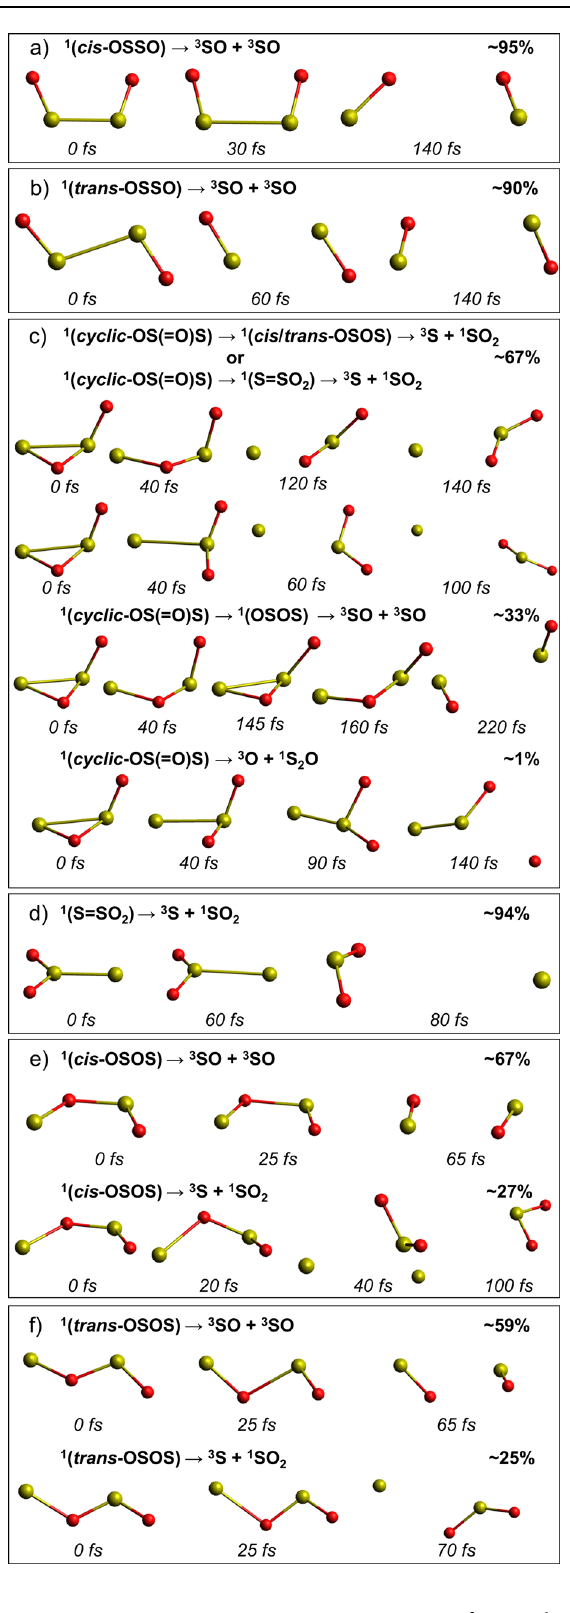
Taking into account the signi fi cant photoproduction of 3 SO from cis -/ trans -OSSO, cyclic -OS(=O)S, and cis -/ trans -OSOS (Fig. 1), formed in situ, we characterized the thermal (i.e., ground-state) deoxygenation reactions (Eqs. 3 and 4) that yield 1 S 2 O, 3 S 2 , and 1 SO 2 (Fig. 2, Supplementary Figs. 25 and 27, and Supplementary Table 6), which open the path toward aerosols (S n O and S n ). Since other species ( 2 NO, 3 O, 3 S, and 2 H) could also produce analogous reactions 12,19,53 , we accurately determined their reactivity with cis - OSSO (Supplementary Table 6 and Supplementary Figs. 28 – 35) to update previous estimations for the rate of these reactions.